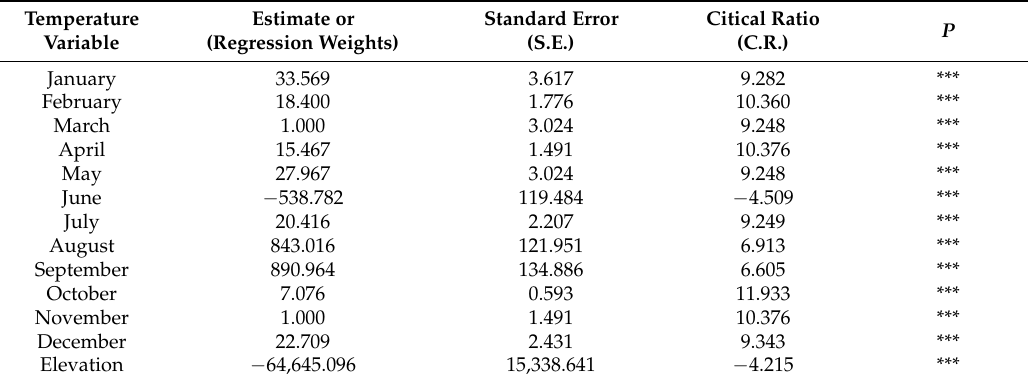
Table 3. The significant correlation coefficient.